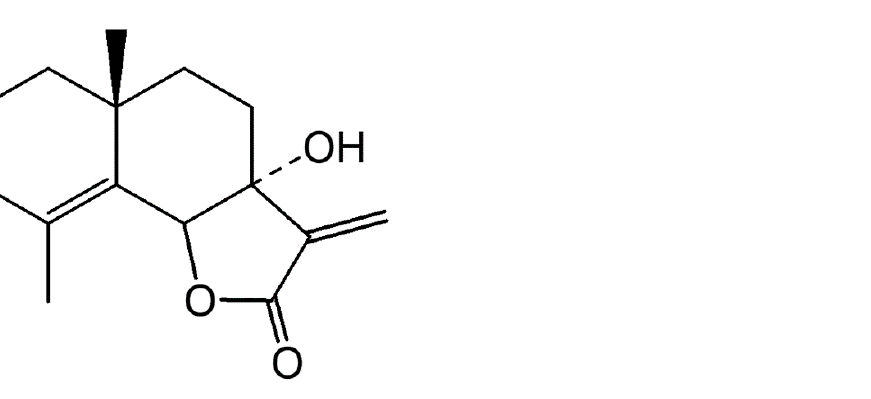
Figure 1. Chemical structure of 7- α -hydroxyfrullanolide extracted from Grangea maderaspatana . Table 1. Cytotoxicities and selectivity indices of 7- α -hydroxyfrullanolide (7HF) in human breast cancer and normal cells at 72 h, as evaluated using MTT assay.